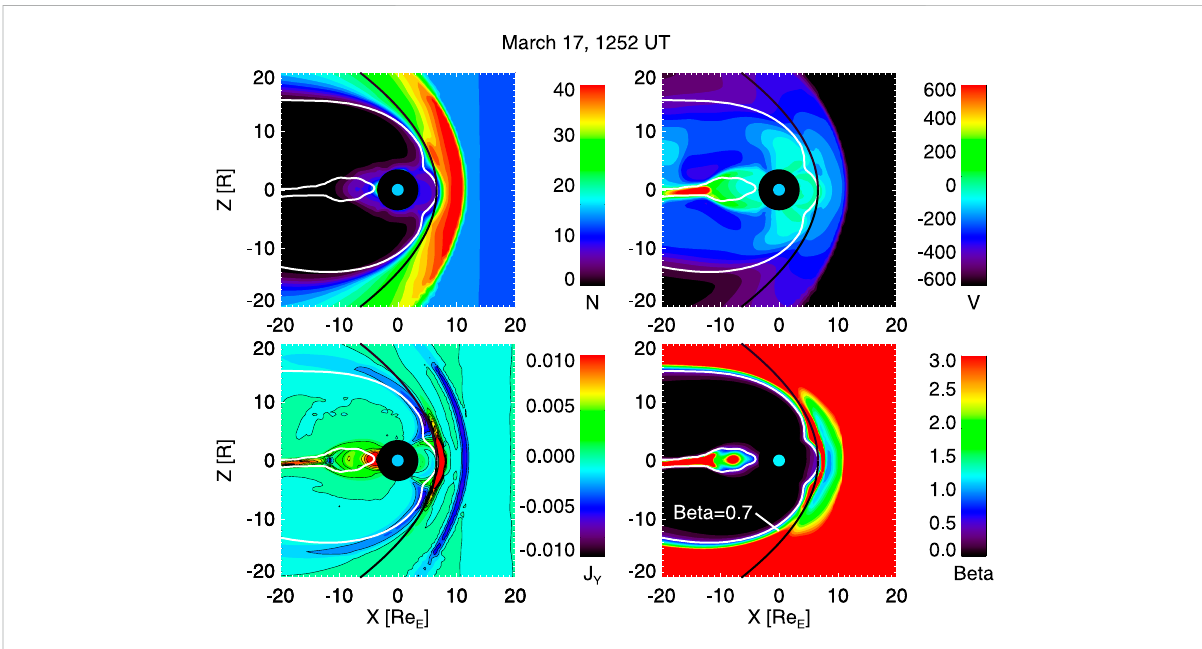
FIGURE 2 Noon-midnightmeridiancutsfromthesimulation.(Topleft)Plasmadensityincm − 3 ;(Topright)Plasmavelocity V X componentinkm/s;(Bottom left) Current density in μ A/m 2 ; and (Bottom right) β * parameter (see text). The white lines show the β * = 0.7 contours, which are used to de fi ne the simulation magnetopause location. The black thick curve shows the Shue magnetopause model (see